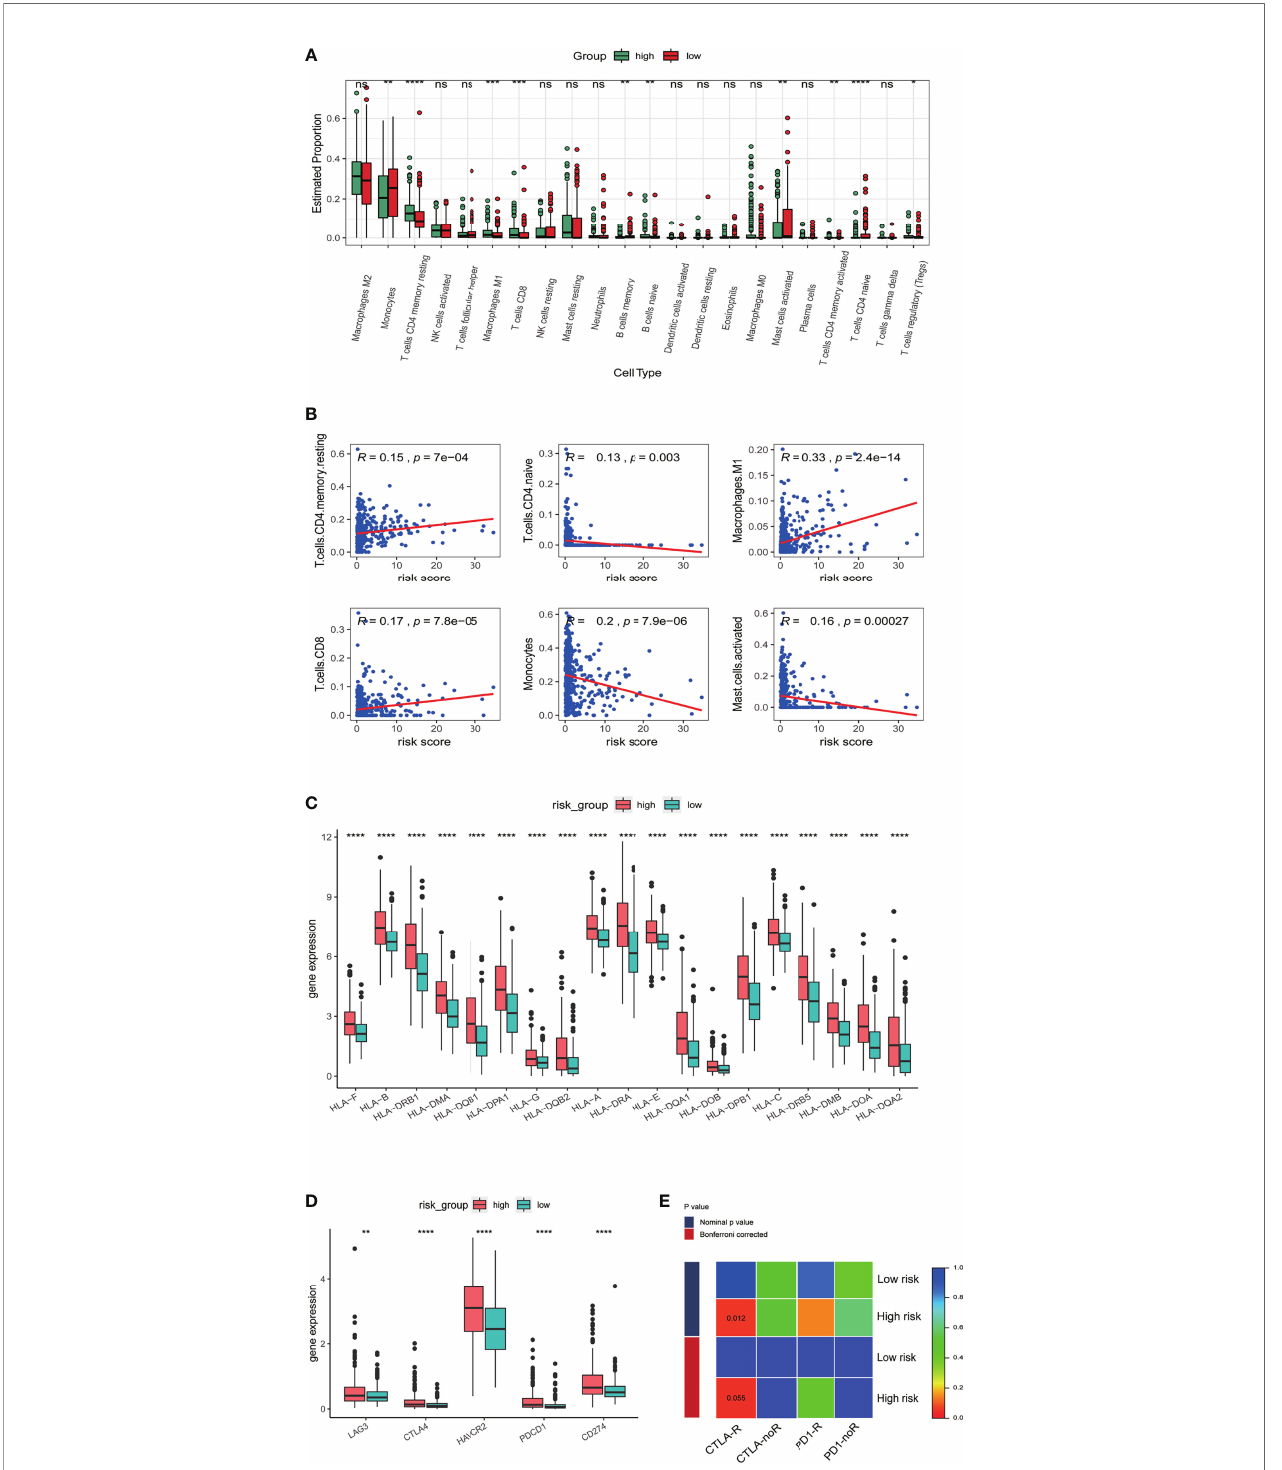
FIGURE 7 | Correlation of the risk score with immune cell in fi ltration and prediction of responses to immune checkpoint inhibitors. (A) Estimated proportion of 22 tumor in fi ltrating immune cells in high and low risk groups. (B) Correlation of risk score with proportion of six tumor-in fi ltrating immune cell types. (C) The expression levels of HLA family genes in low- and high-risk groups in TCGA database. (D) The expression levels of CD274 (PD-L1), CTLA4, HAVCR2, LAG3, and PDCD1 (PD1) in low- and high-risk groups in TCGA database. (E) Sensibility of patient responses to PD1 and CTLA4 inhibitors in different risk groups. *p<0.5, **p<0.01, ***p<0.001, ****p<0.0001, ns, no signi fi